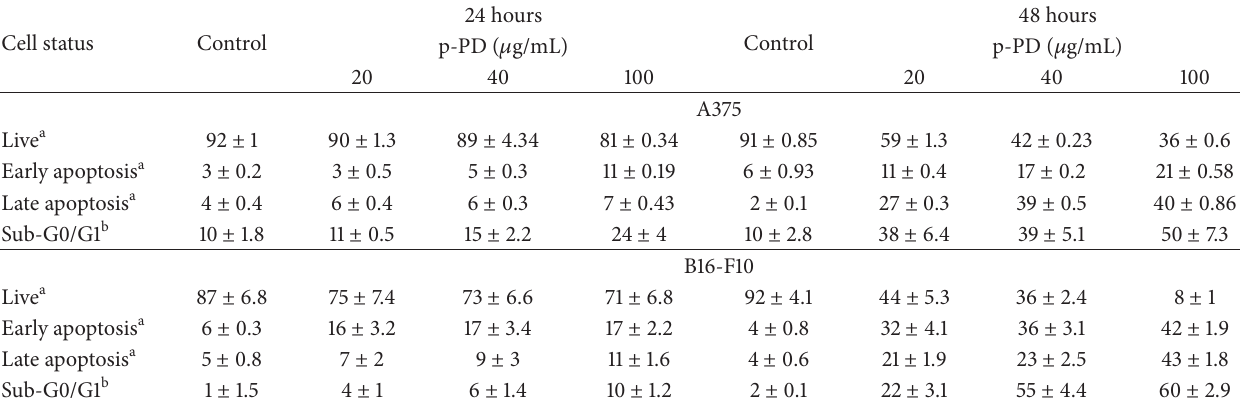
Table 3: Quantification of